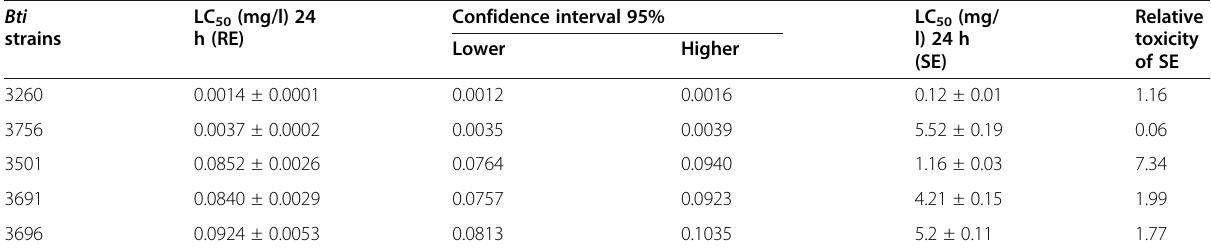
Table 2 Concentration mortality response of Aedes aegypti 3rd instar larvae to Bacillus thuringiensis subsp. israelensis ( Bti ) reactivated strain extracts (RE) and stored extracts (SE) Bti